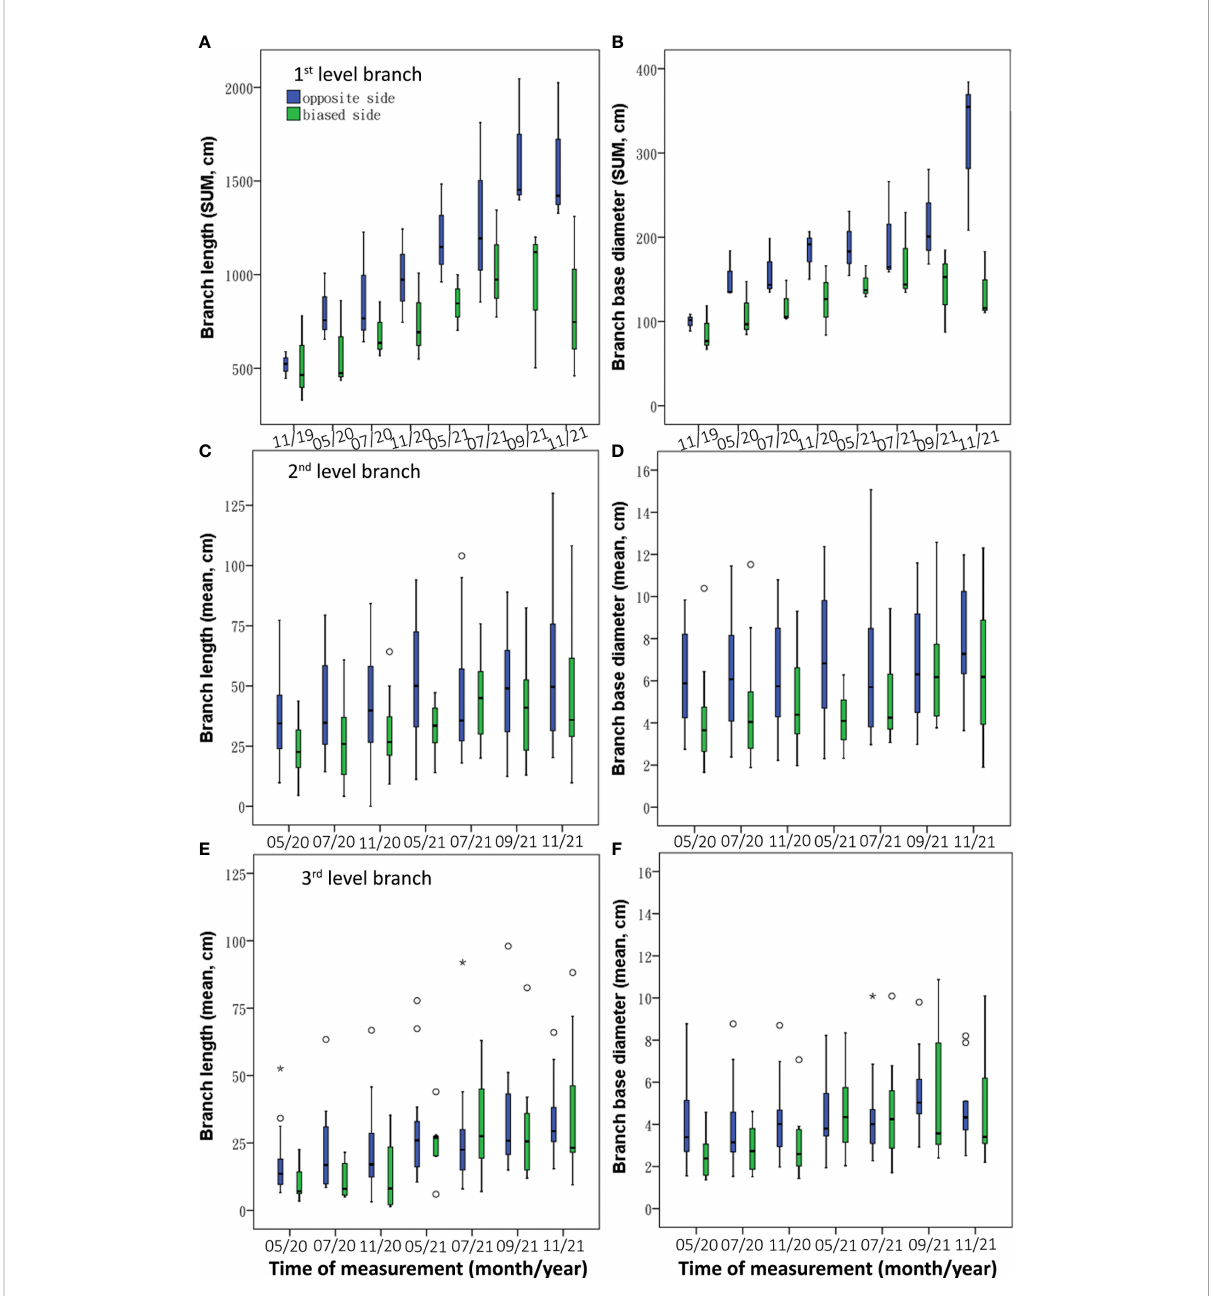
FIGURE 5 Temporal dynamics of branch variables [length (A, C, E) and base diameter (B, D, F) ] between 0 and 1 sides under BRT